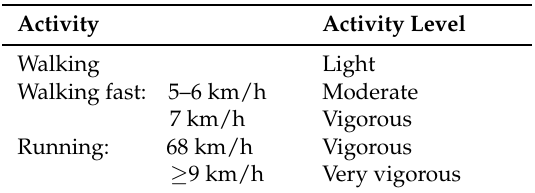
Table 1. Activity Category and Corresponding Activity Level.